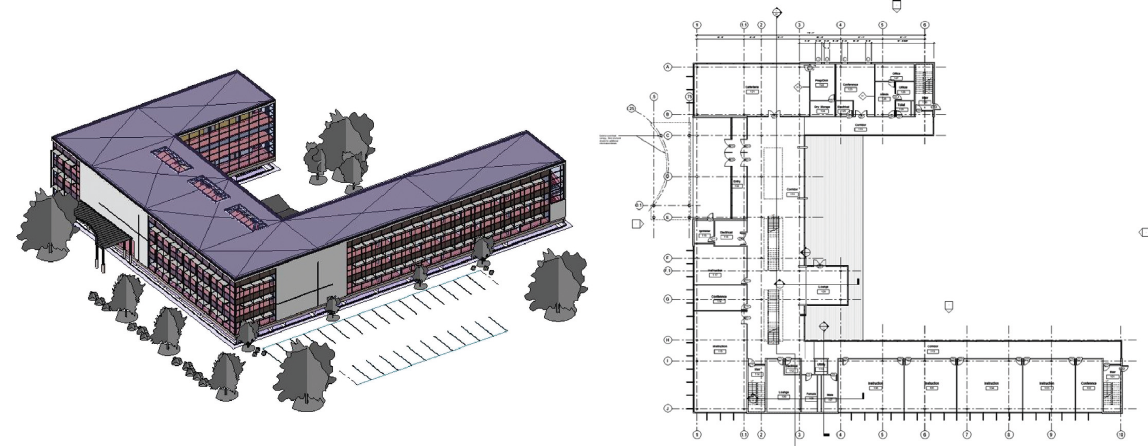
Figure 10: Isometric view and foundation plan of school building.